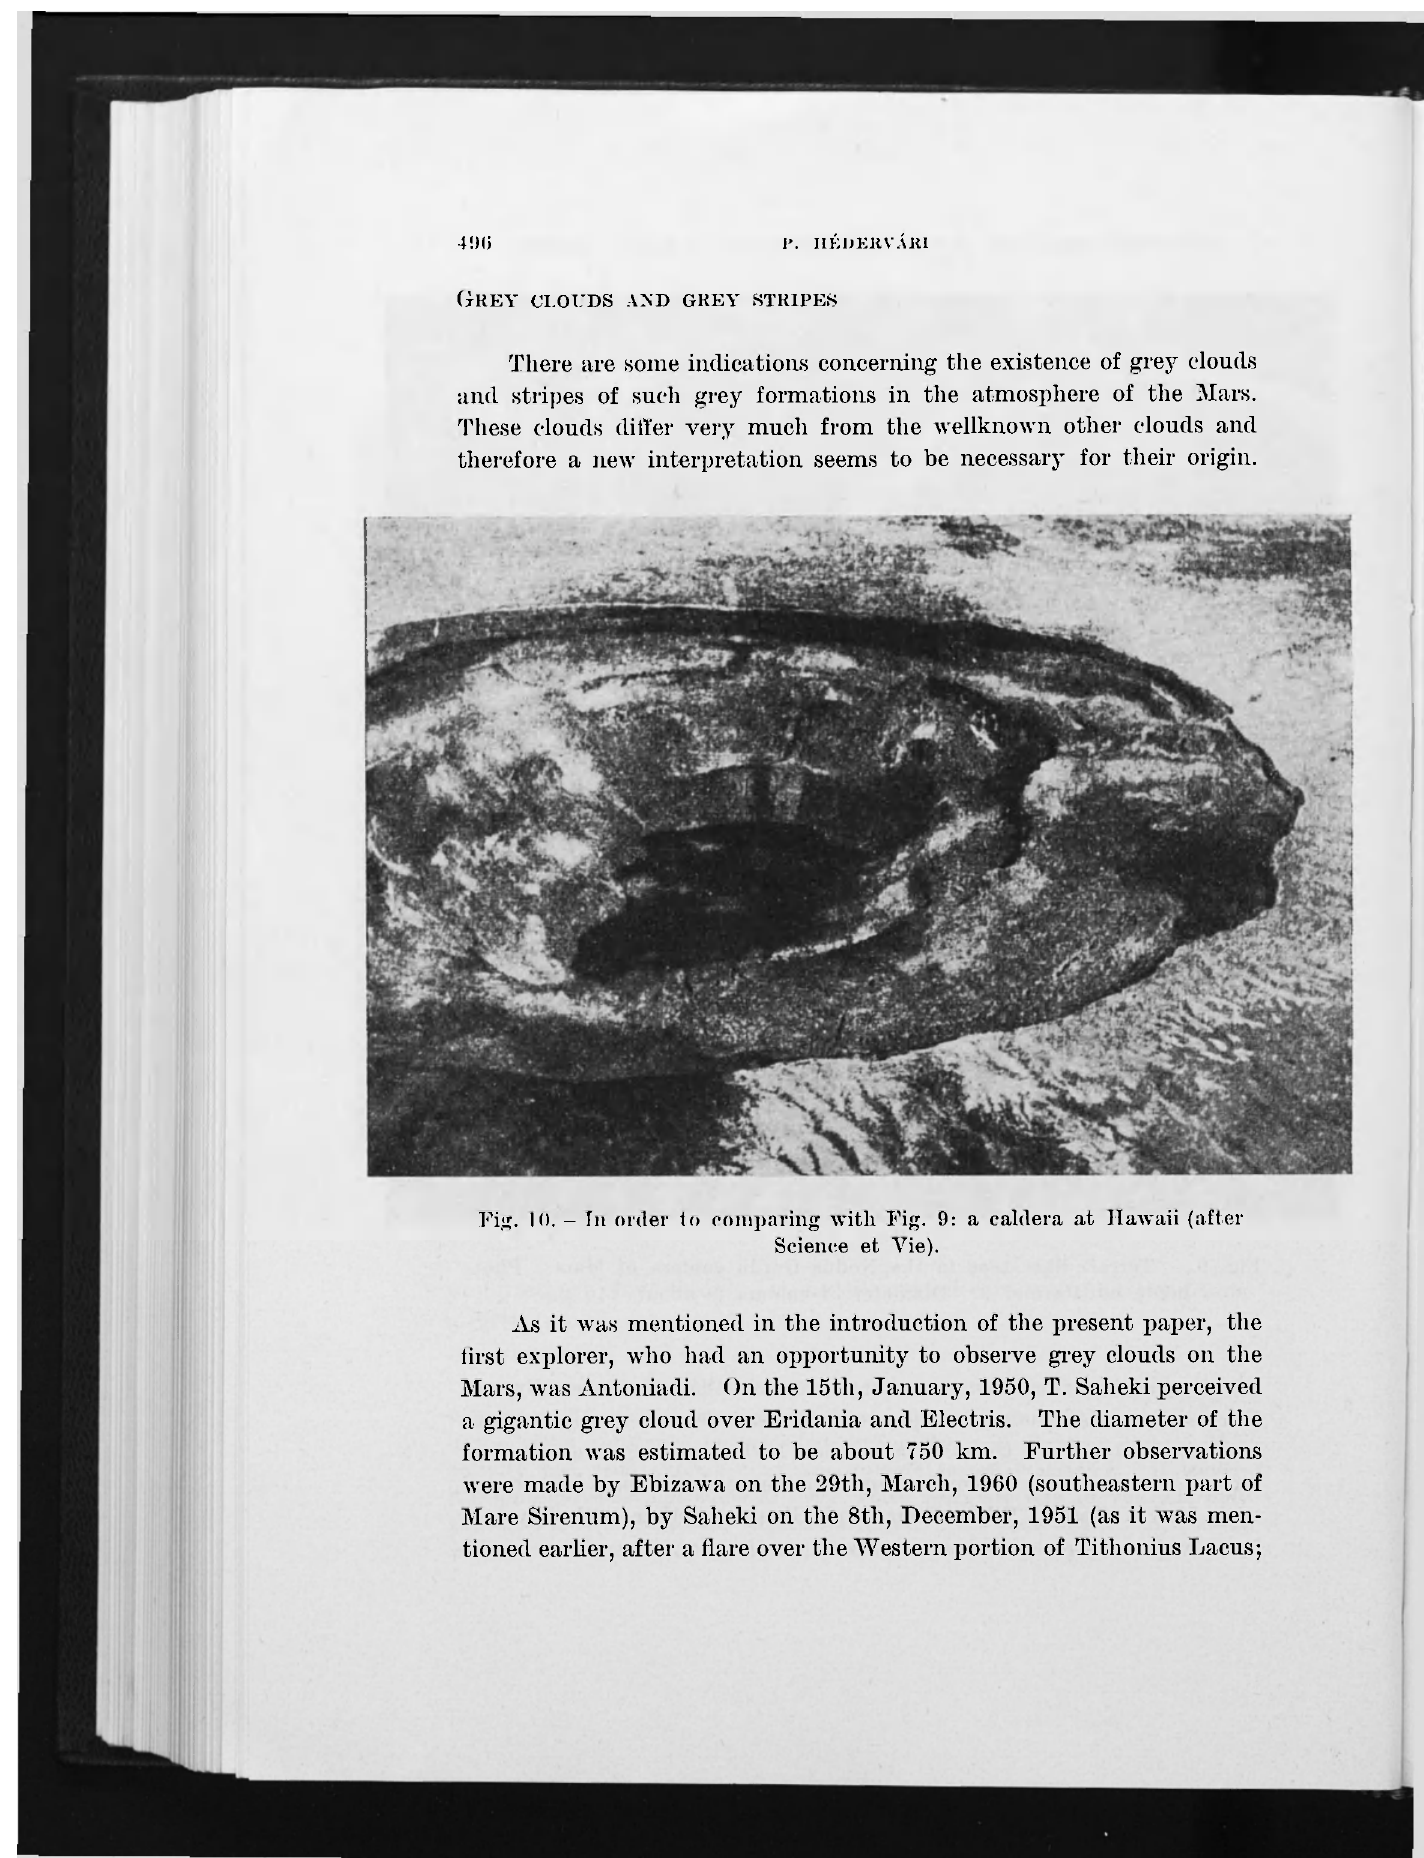
GREY CI.OUDS AND GREY STRIPES There are some indications concerning the existence of grey clouds and stripes of such grey formations in the atmosphere of the Mars.